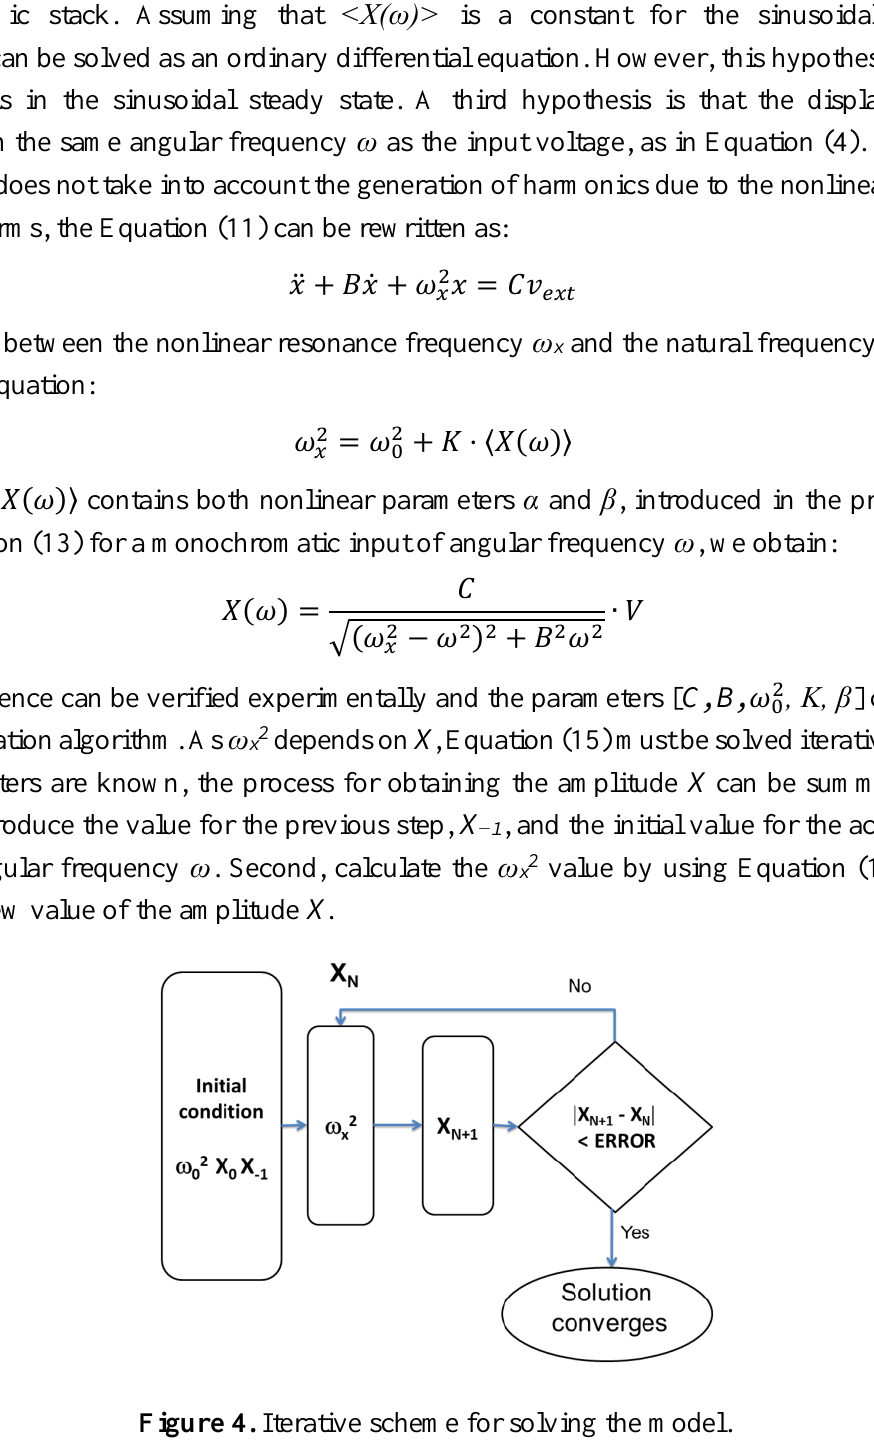
Figure 4. Iterative scheme for solving the